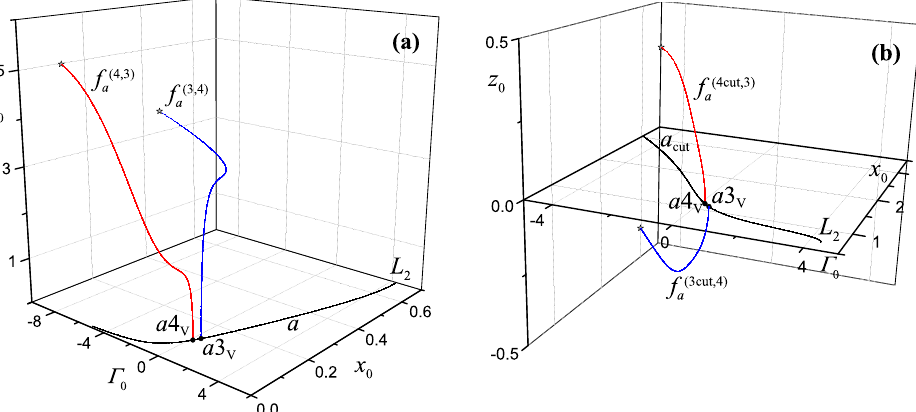
Figure 3. 3D families bifurcating from the VSR orbits a 3 v and a 4 v of family a . ( a ) Bifurcating families starting from the initial condition ( Γ 0 , x 0 ) of the planar family and ( b ) Bifurcating families starting from the initial condition ( Γ 0 , x cut ) of the planar family. Grey star indicates that a family goes to collision